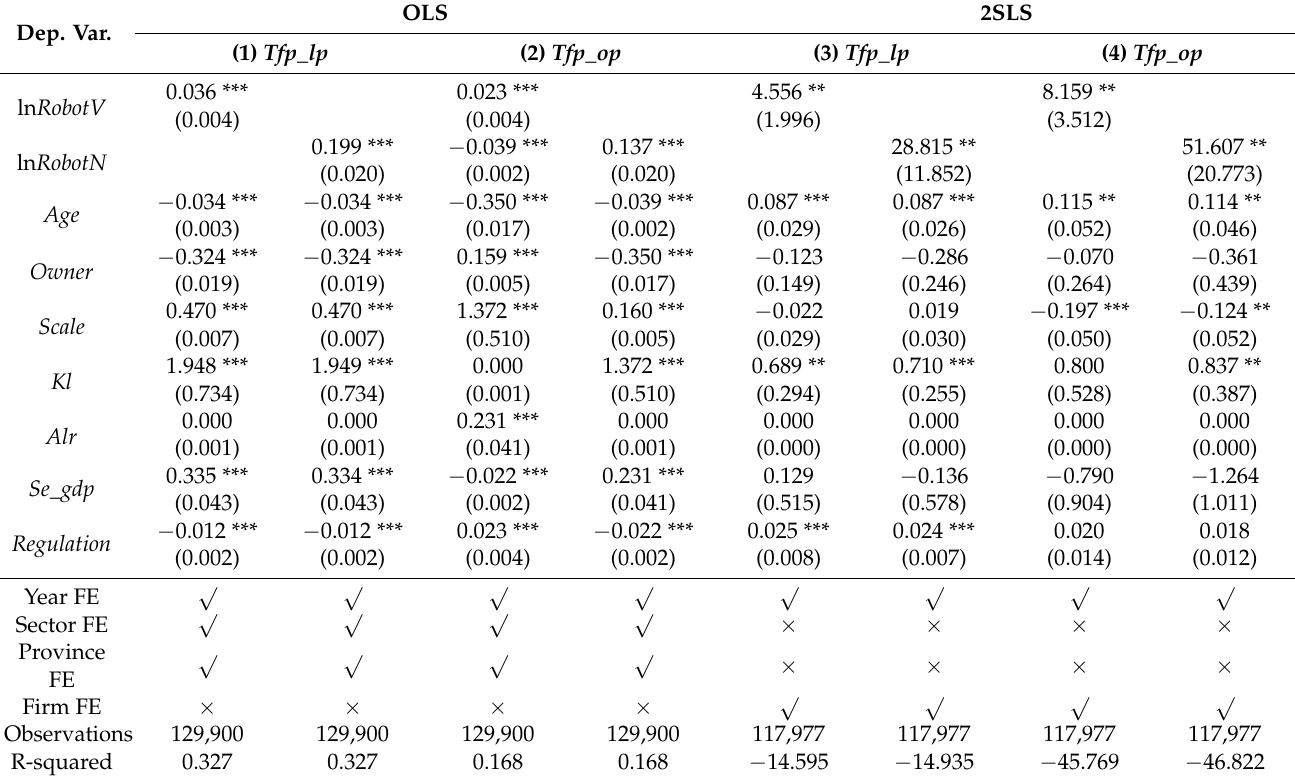
Table 14. Impact of robot application on total factor productivity of enterprises. Dep.